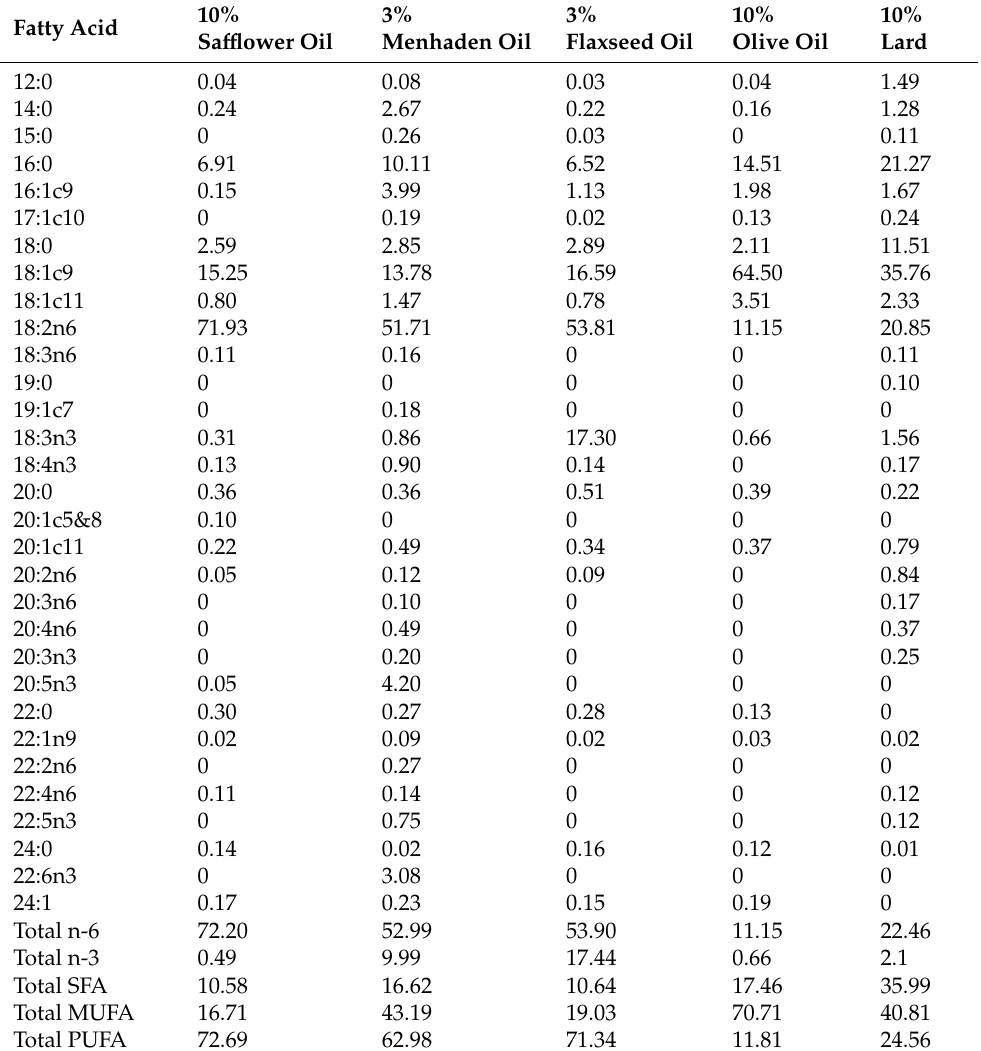
Table 1. Fatty acid composition of